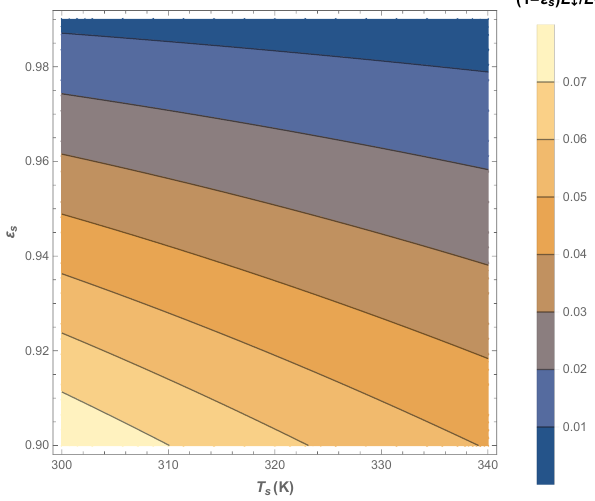
Figure A1. Ratio between the second part of Eq. (10) (i.e. ( 1 − ε s )L ↓ ) and total outgoing longwave radiation (i.e. ε s σT 4 s + ( 1 − ε s )L ↓ ) at a constant air temperature of 20 ◦